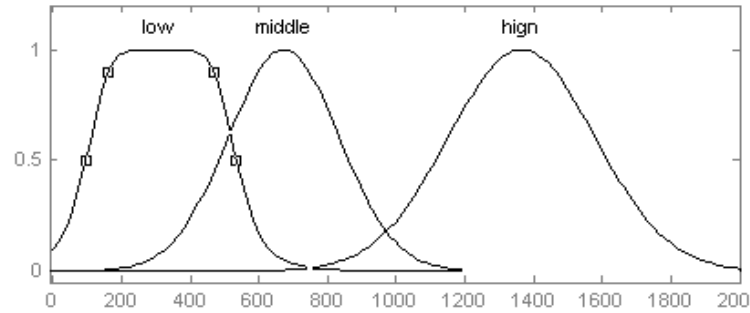
Figure 5. Membership functions of driver’s braking force commands.